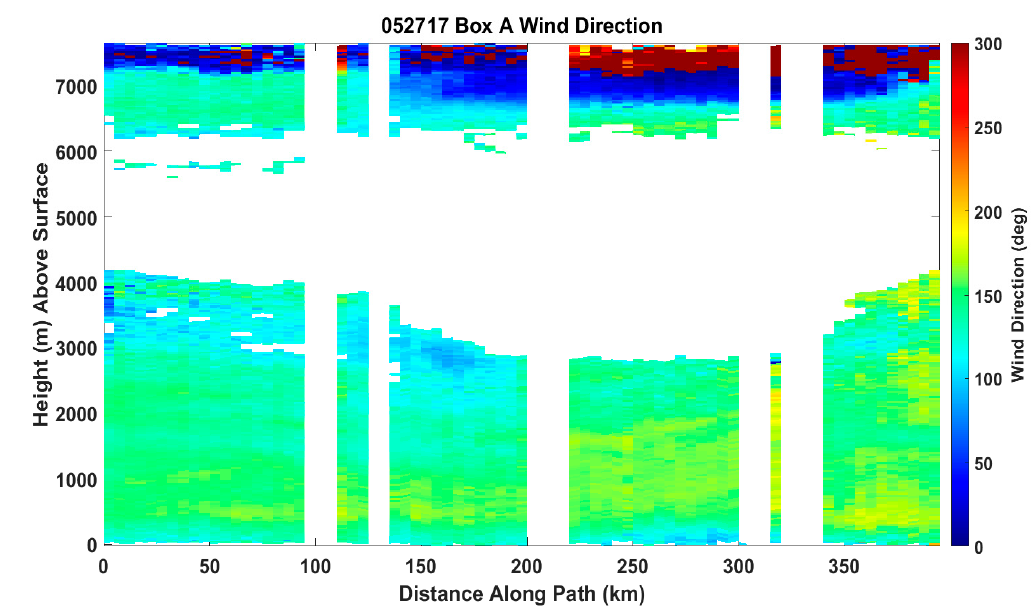
Figure 15. Curtain of DAWN wind direction profiles around Box A between 200005Z and 205006Z on 27 May 2017.